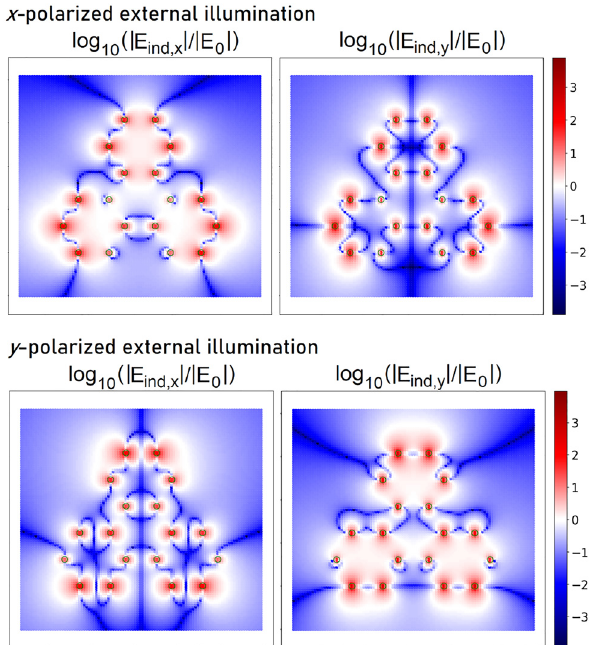
Figure 5: Distribution of the x -components (left) and y -components (right)oftheelectricfieldthatisinducedaroundan18-atomgraphene nanoflake due to an external illumination polarized either in x - direction (upper panels) or y -direction (lower